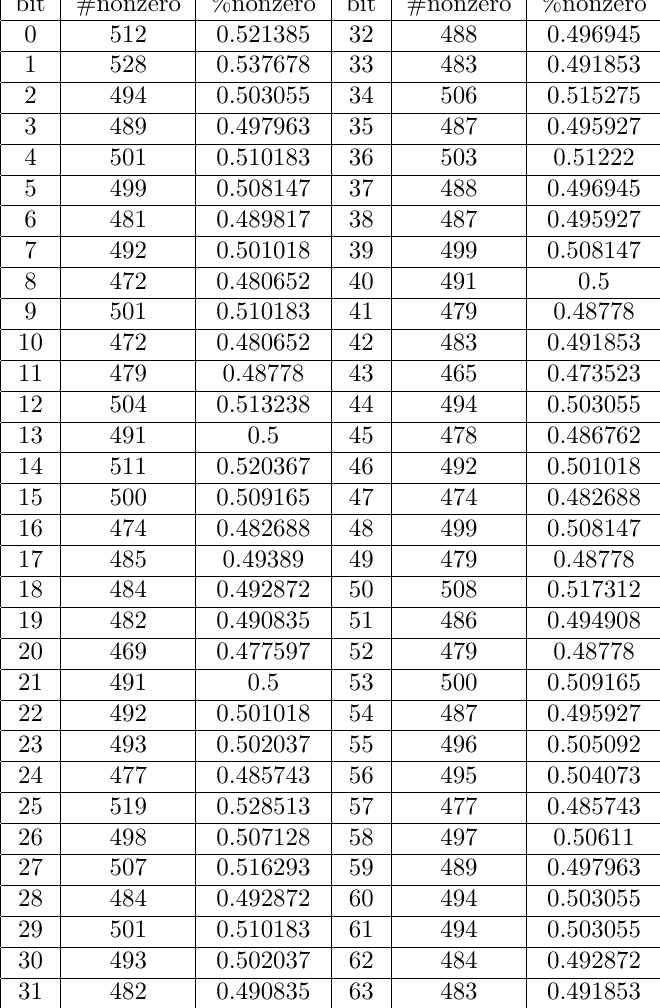
Table 10: Statistics of Nonzero Cube Sums in the 64-bit Output of 6-round Ascon